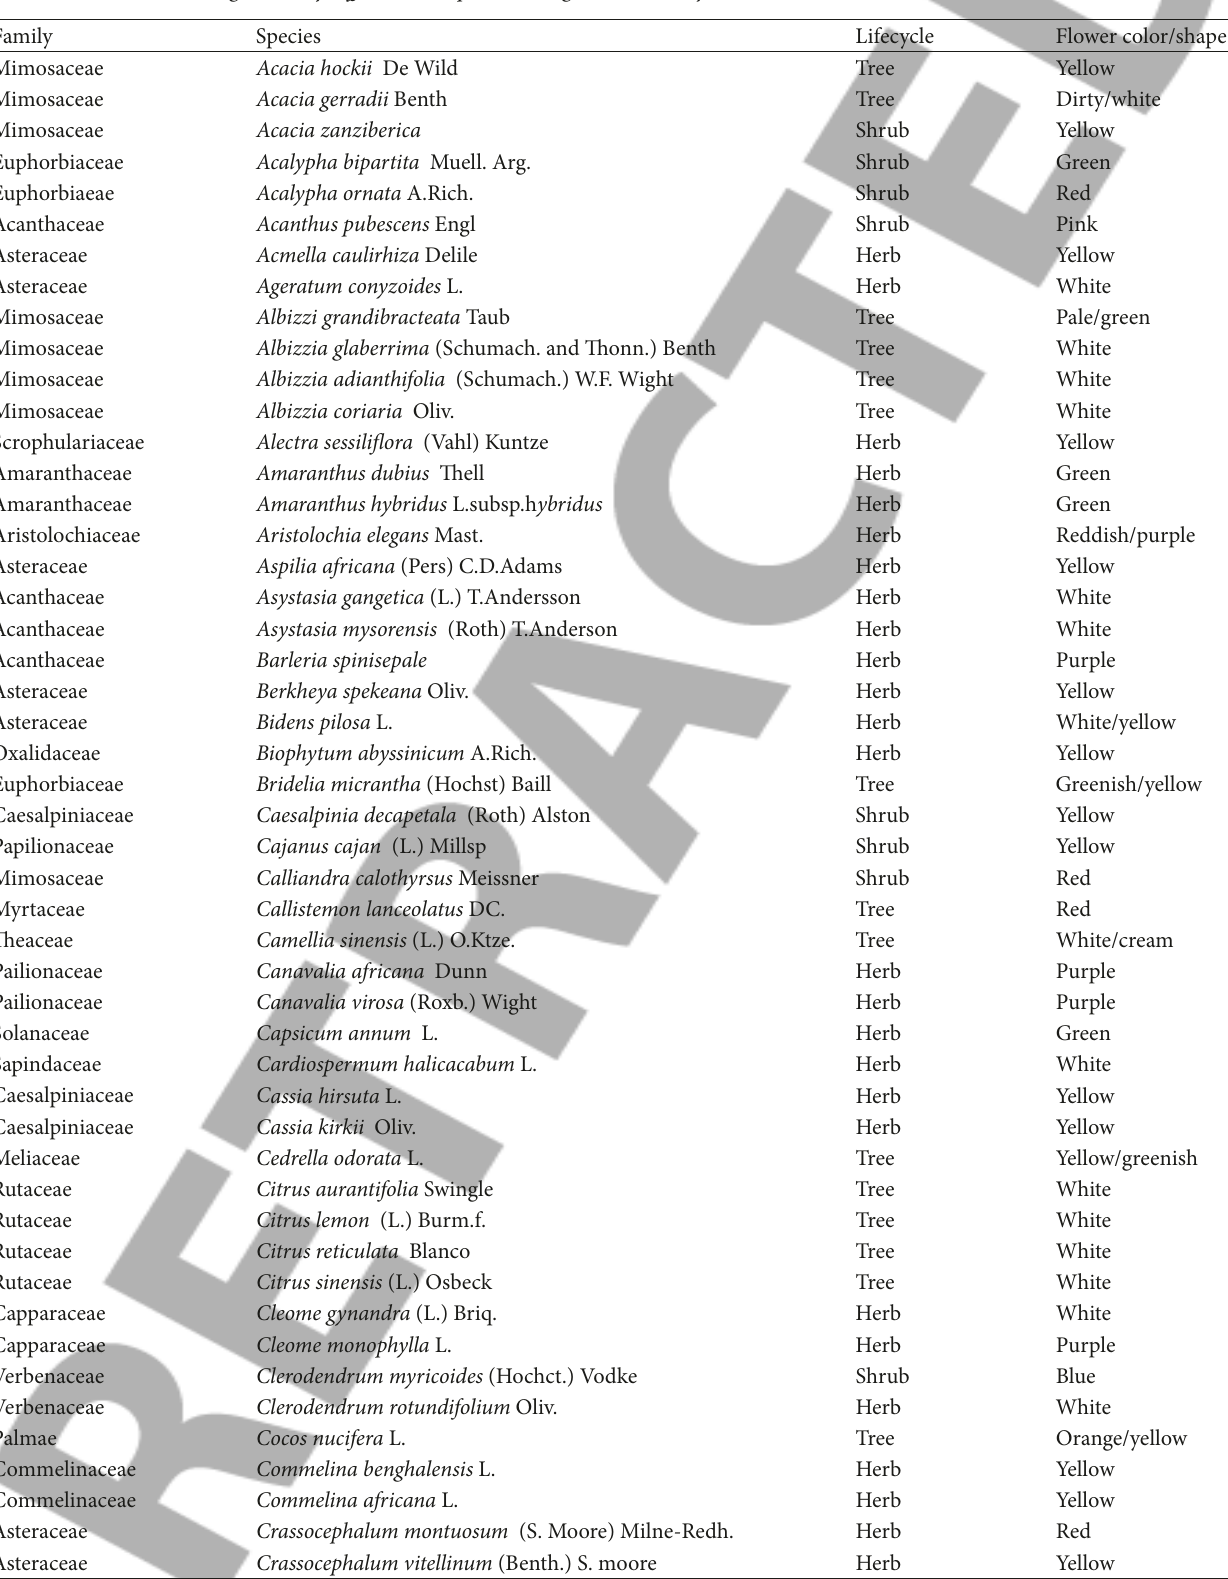
Table 7: List of common wild flowering plant species visited by bees during floral resources collection in the coffee-banana farming system of central Uganda. Species are arranged per family, life cycle type , and type of flower colour/shape. These are plant species met in blooming periods and that were observed being visited by different bees species during transect surveys .